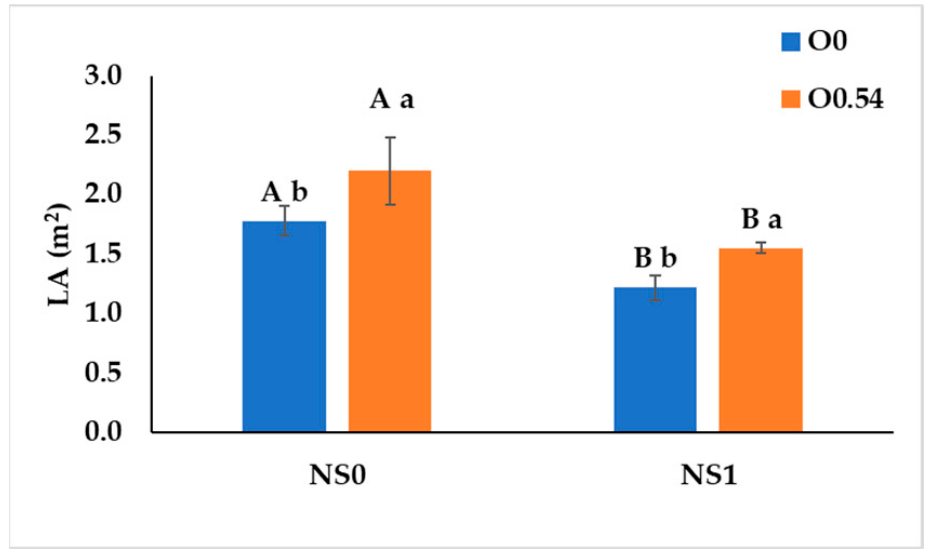
Figure 2. Interactions between fertigation treatments and O 3 supply on leaf area in tomato plants. The comparison between the ozone supplies is assessed with lowercase letters. Capital letters are used to analyze the comparability of fertigation treatments. Different letters denote significant treatment changes (LSD test, p <